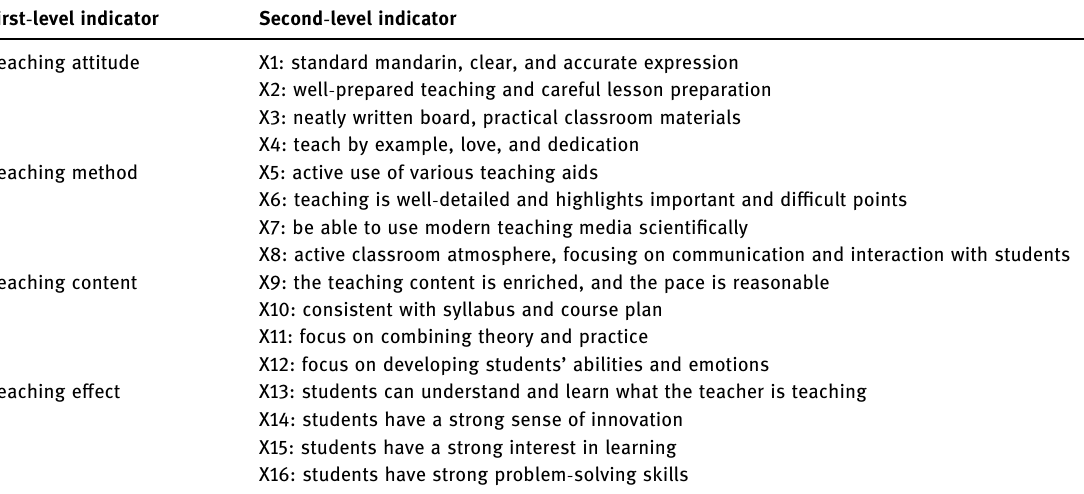
Table 1: Teaching quality evaluation indicator system First - level